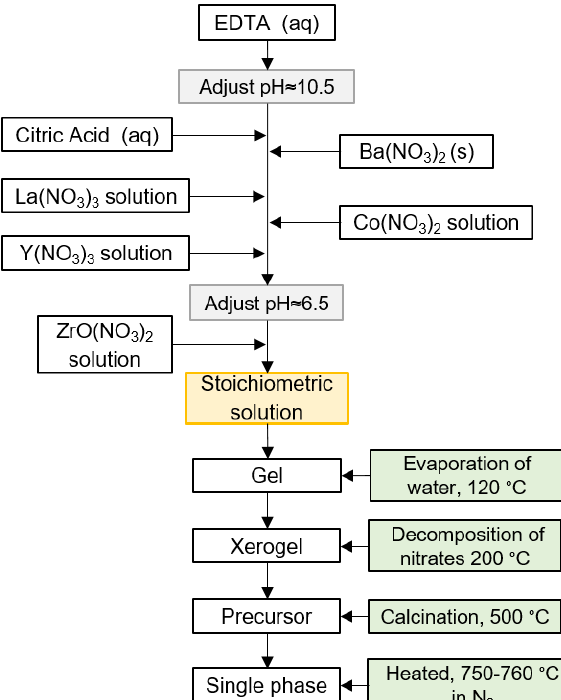
Figure 1. Flow chart of the modified Pechini synthesis of La 1-x Ba x CoO 3- δ -BaZr 1-z-y Y z Co y O 3- δ -based composites. The precursor is annealed in N 2 to form a single-phase material stable at room temperature.